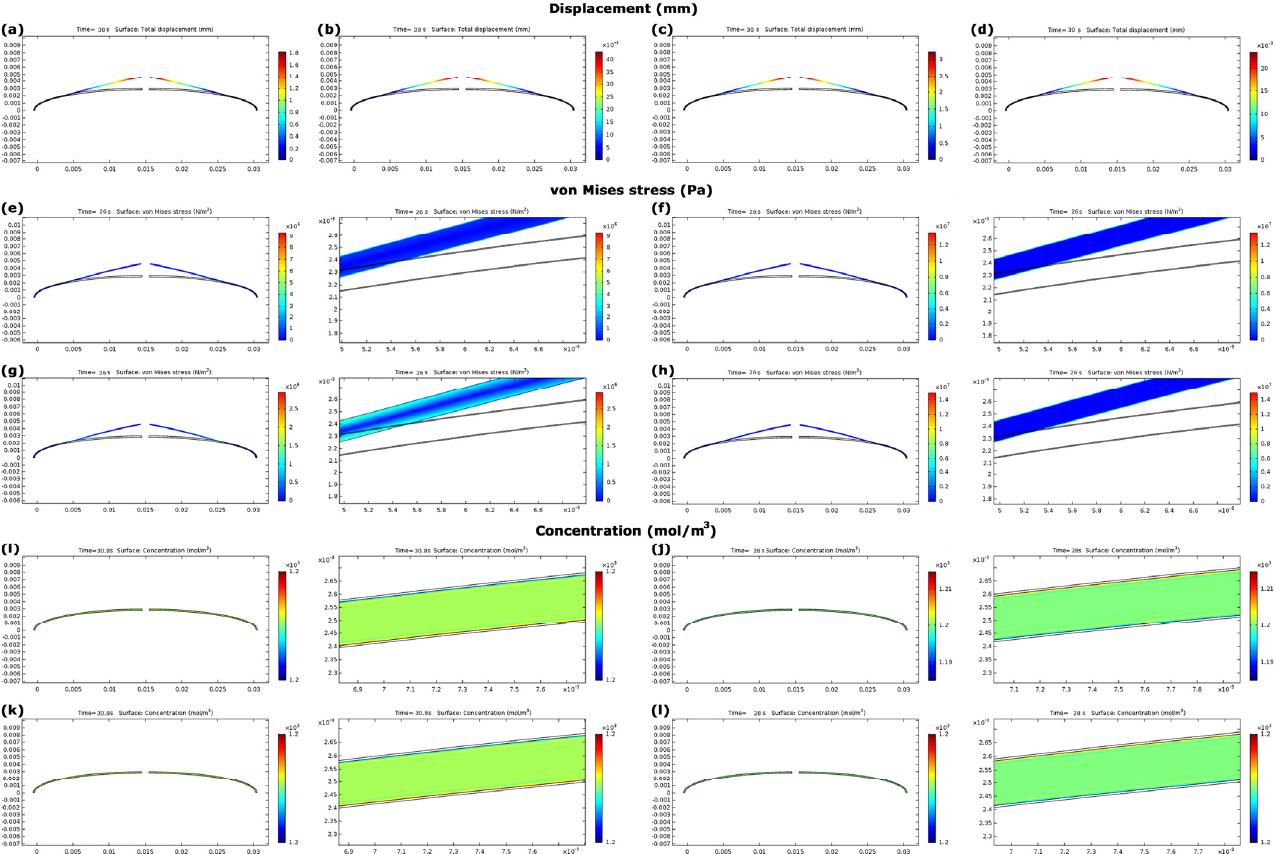
Figure 9. ( a – d ) show the linear displacement distributions in IPMC with BSA–CNT, gold, MCC–CNT, and platinum electrodes, respectively. ( e – h ) show the distributions of von Mises stress in IPMC with BSA–CNT, gold, MCC–CNT, and platinum electrodes with their zoom panels, respectively. ( i – l ) show the distributions of cation concentration in IPMC with BSA–CNT, gold, MCC–CNT, and platinum elec- trodes with their zoom panels, respectively. The panels are not to